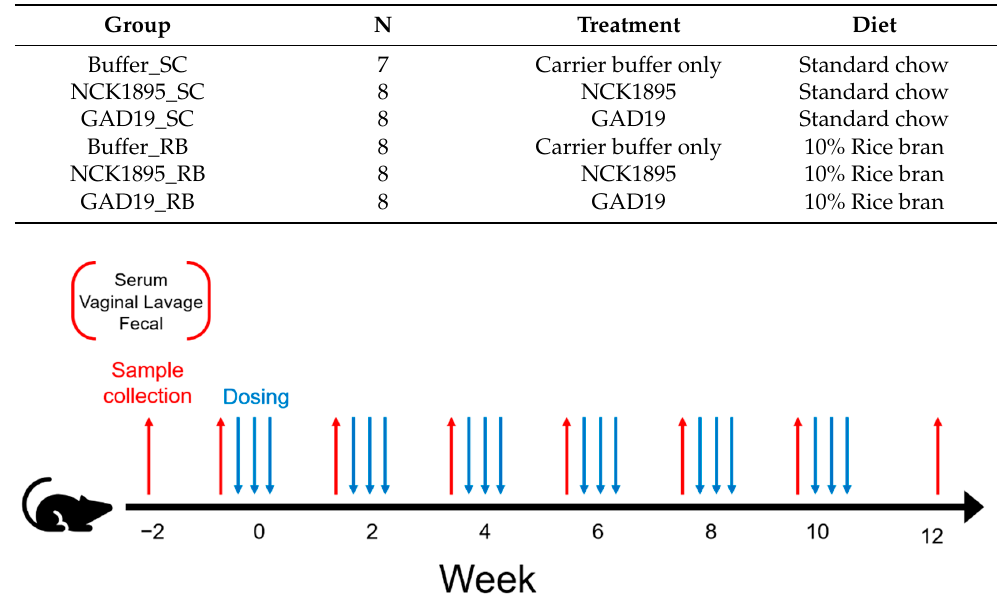
Table 1. Experimental groups with assigned vaccine treatment and diet. Eight mice were assigned to each experimental group, except for Buffer_SC, where seven mice were used, for a total of forty-seven mice. All mice received the same number of treatment doses and were repeatedly, biweekly measured over 8 time periods, starting at week 2, for immune response and to obtain fecal samples to study the microbiome. This resulted in a total number of 376 samples per type of immune response (i.e., fecal IgA, vaginal IgA, or serum IgG), for a grand total of 1128 samples, and per IgA-coating type (i.e., IgA positive, IgA negative, or whole microbiome), also for a grand total of 1128 samples.